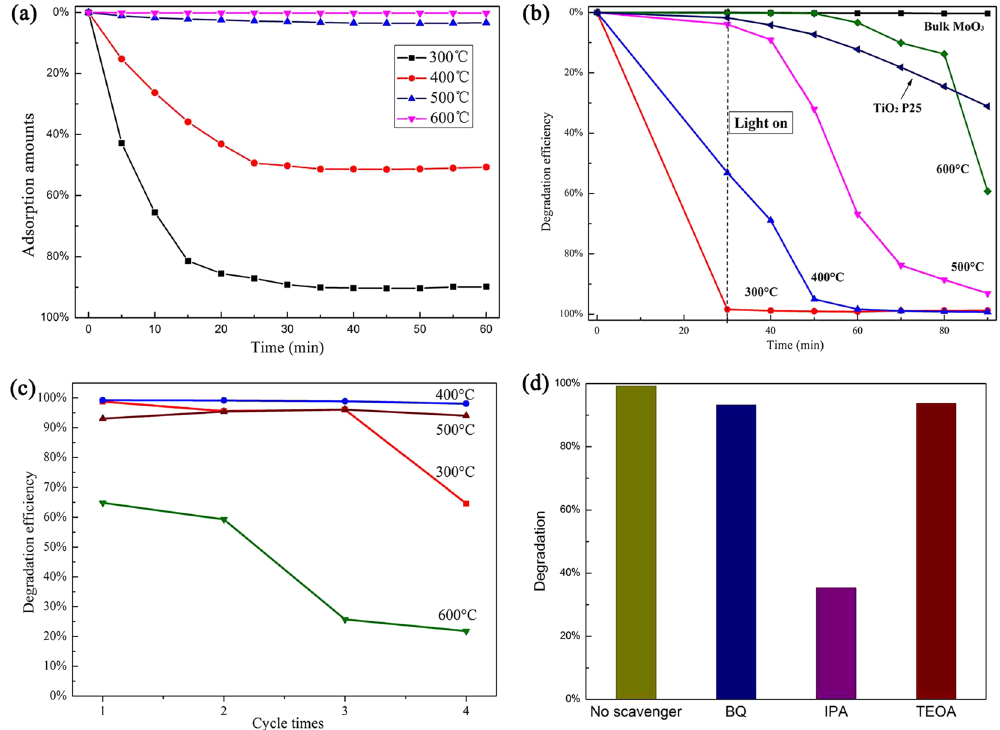
Figure 10. ( a ) Variation of the relative MB concentration during its adsorption over as-prepared MoO 3 . ( b ) Decolorization efficiency for the degradation of MB under visible light for first time. ( c ) Photocatalytic activity for four cycles. ( d ) Effect of different scavengers on degradation efficiency of MB.